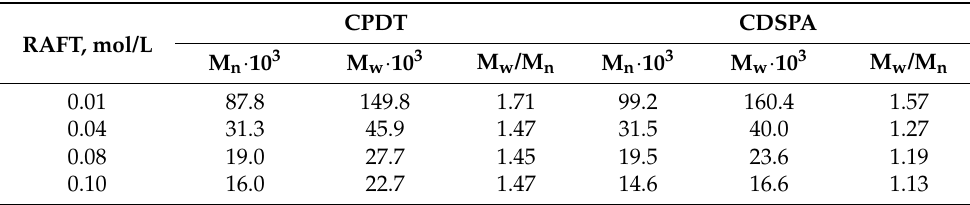
Table 1. Molecular weight characteristics of polyMA polymers synthesized in the presence of CPDT and CDSPA, AIBN = 0.002 mol/L, T = 70 ◦ C. RAFT, mol/L